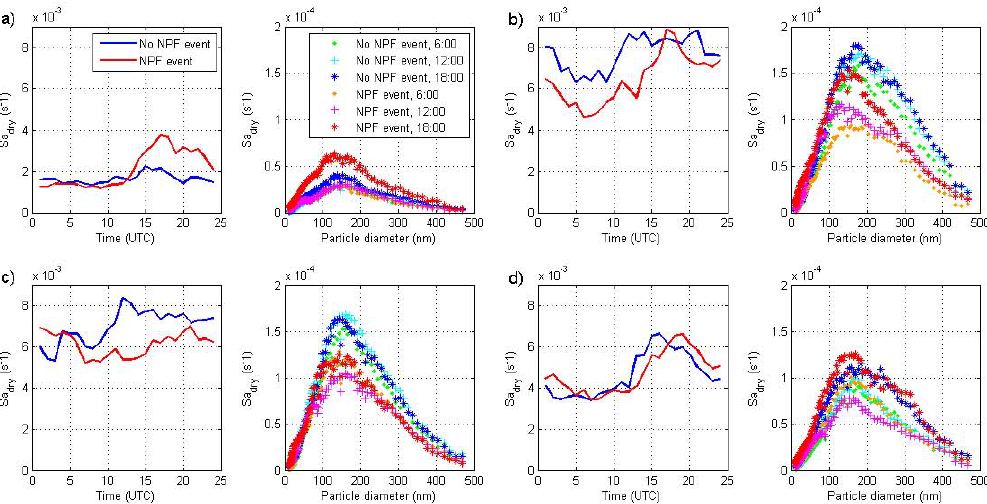
Fig. 9. Aerosol ion sink based on dry SMPS size distribution in (a) winter, (b) spring, (c) summer and (d) fall. For each season, the figure on the left represents the diurnal variability of the median sink; the figure on the right represents the hourly median size distributions of the sink at 06:00, 12:00 and 18:00UTC. February 2007–February 2012, Puy de Dôme.